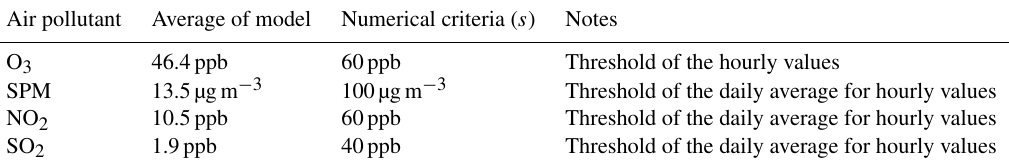
Table 1. Values of numerical criteria ( s ), O 3 , suspended particulate matter (SPM), NO 2 , and SO 2 used in this study. We used the criteria of the Japanese Environmental Quality Standards (JEQS) given by the Ministry of the Environment (MOE) of Japan. Averages of air pollutant amounts calculated by the model for all Japanese municipalities over the study period are shown. Note: ppb – parts per